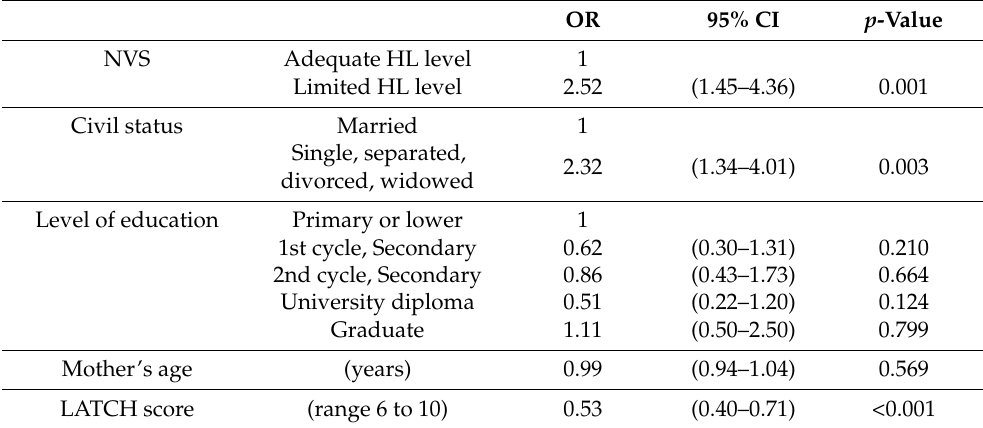
Table 4. Multivariate logistic model for EBF cessation before 6